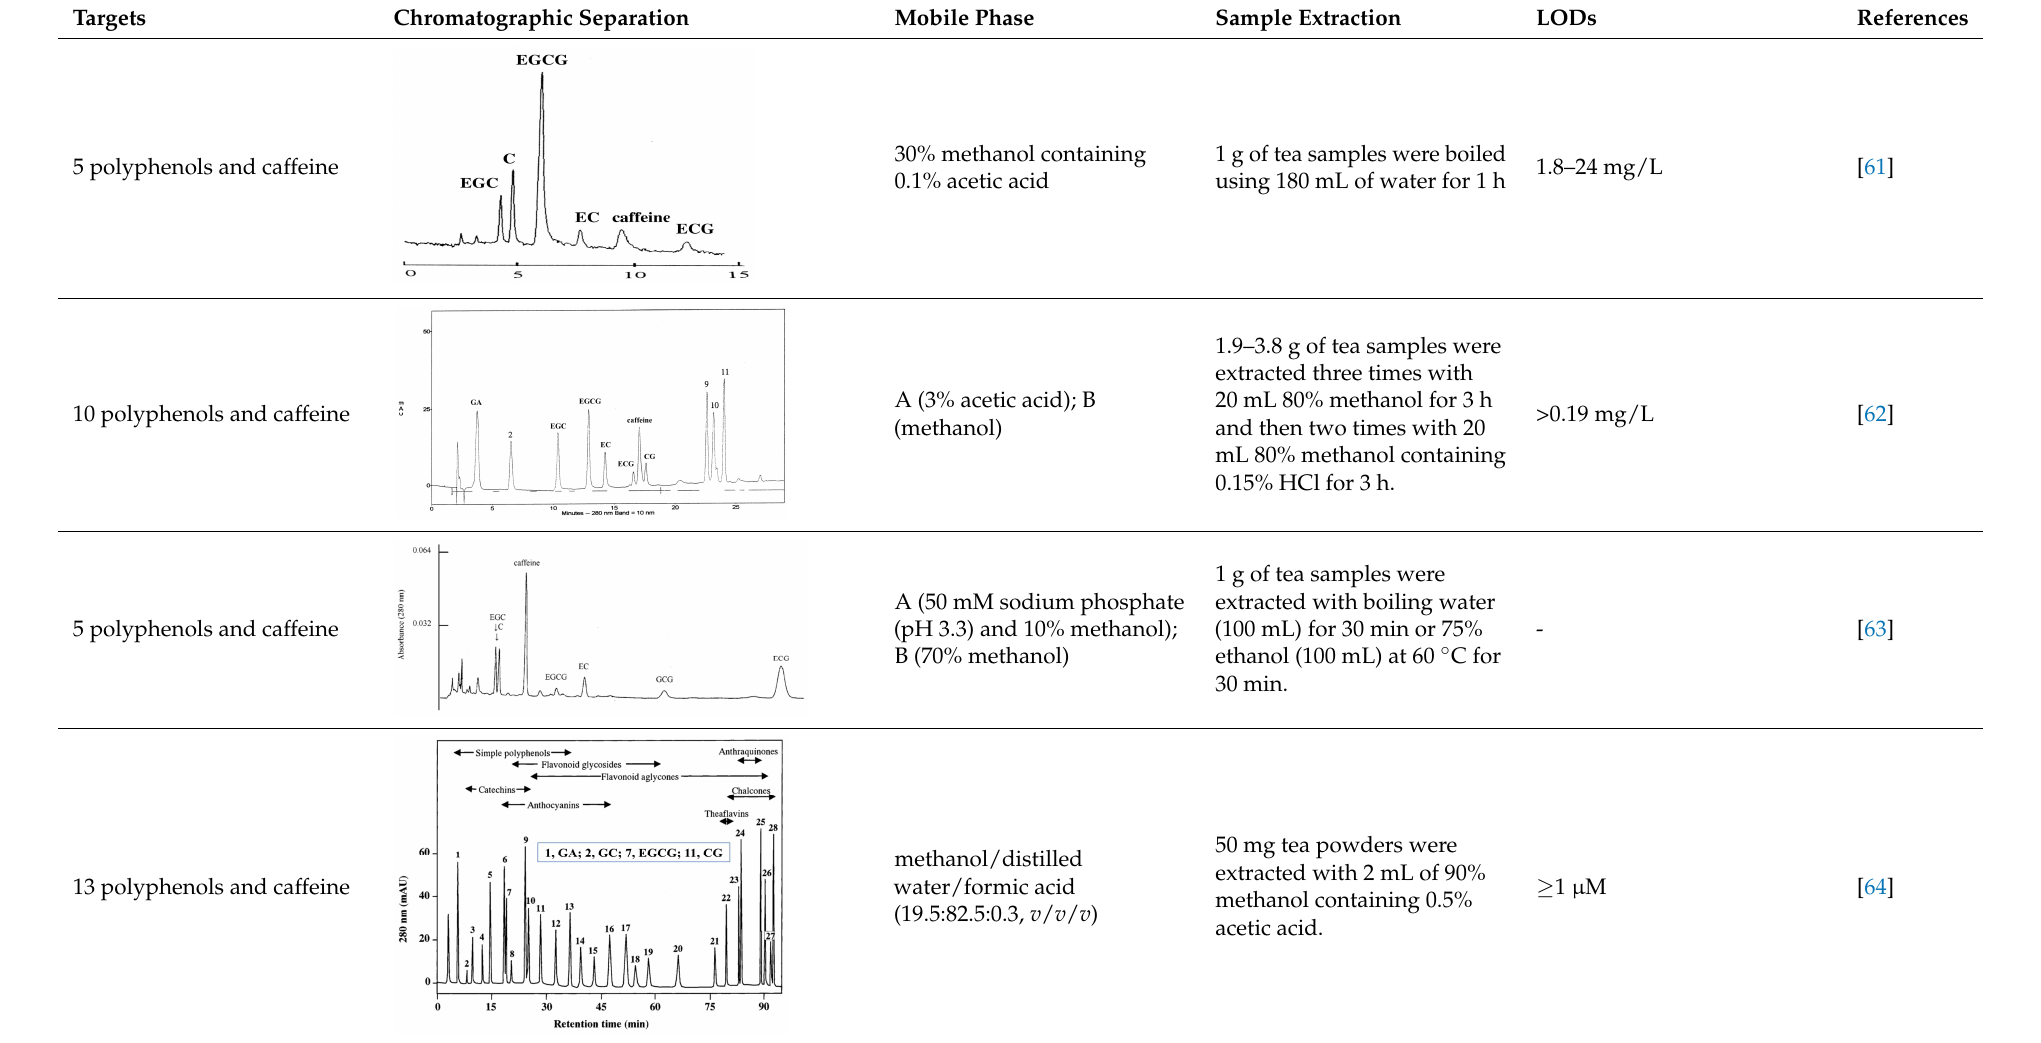
Table 2. Recent applications of HPLC analysis of individual polyphenols in tea.